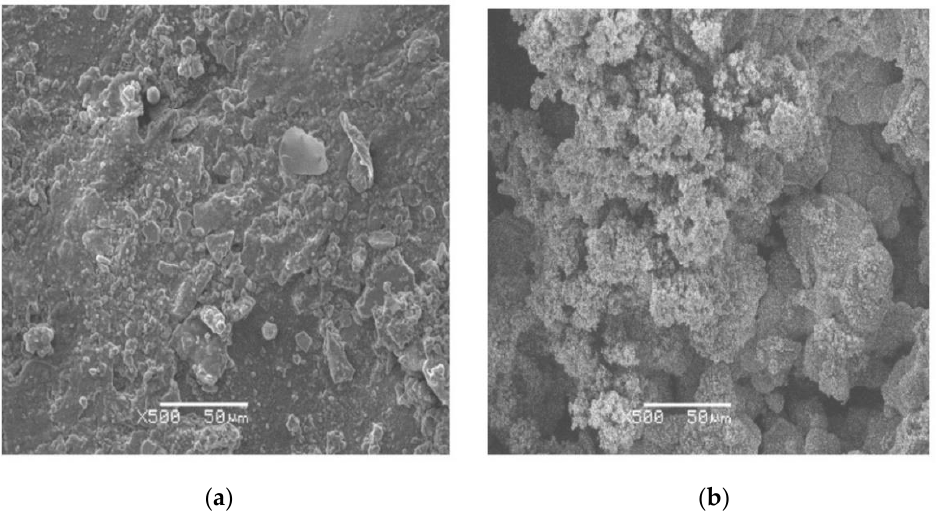
Figure 5. The structure of the sterile coupon ( a ) and coupon with formed biofilm ( b ).